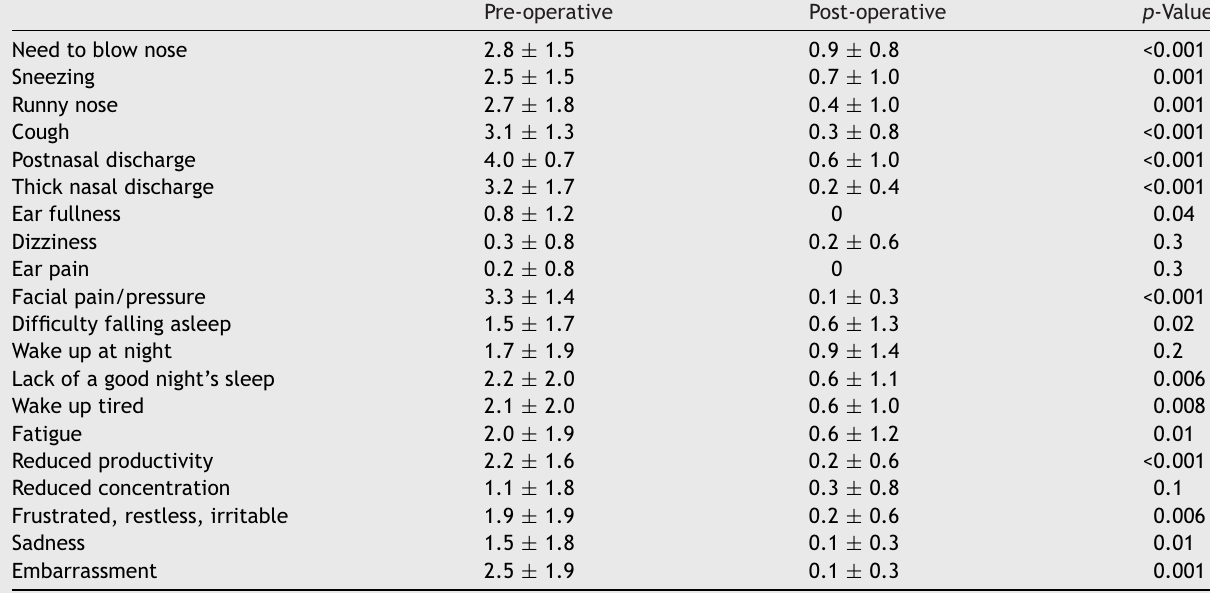
Comparison of Sino-Nasal Outcome Questionnaire Test-20 [SNOT-20] scores per item (mean ± DP) between pre- and postoperative period ( n = 13).